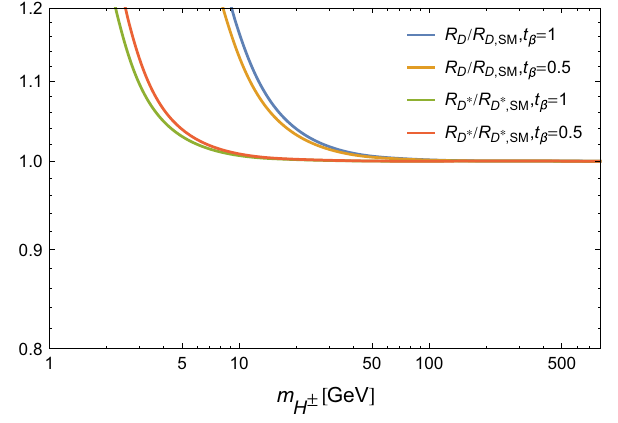
Fig. 6 The ratios of R D / R D , SM and R D ∗ / R D ∗ , SM as the functions of charged Higgs mass for given tan β